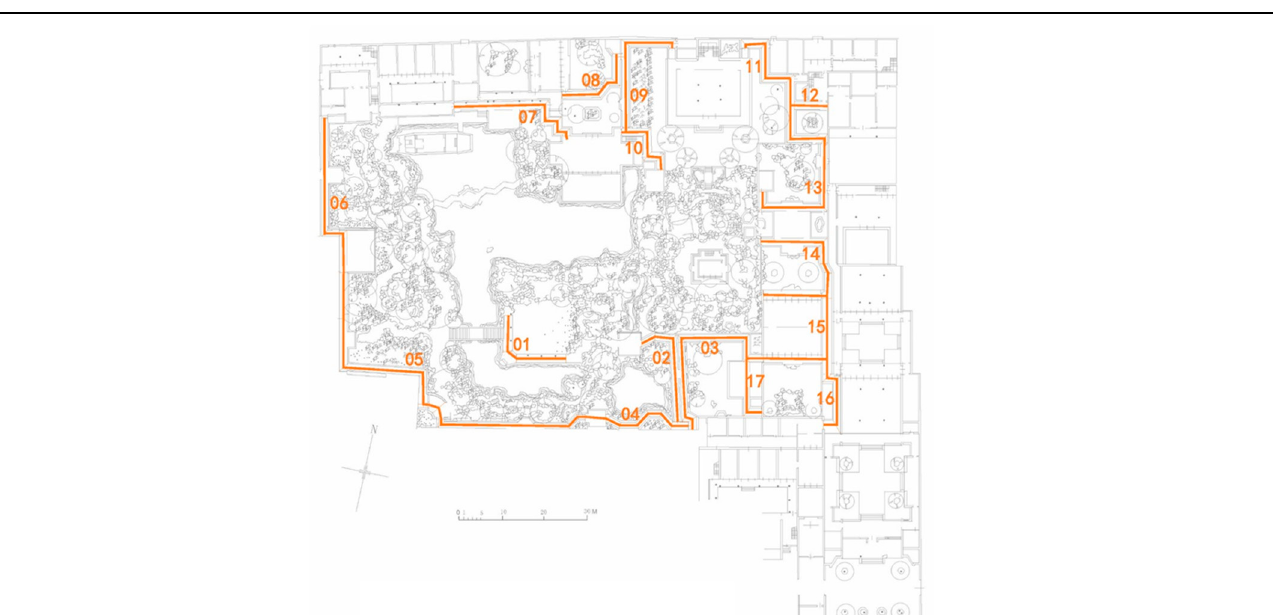
Table A16. Lion Forest Garden, corridor.